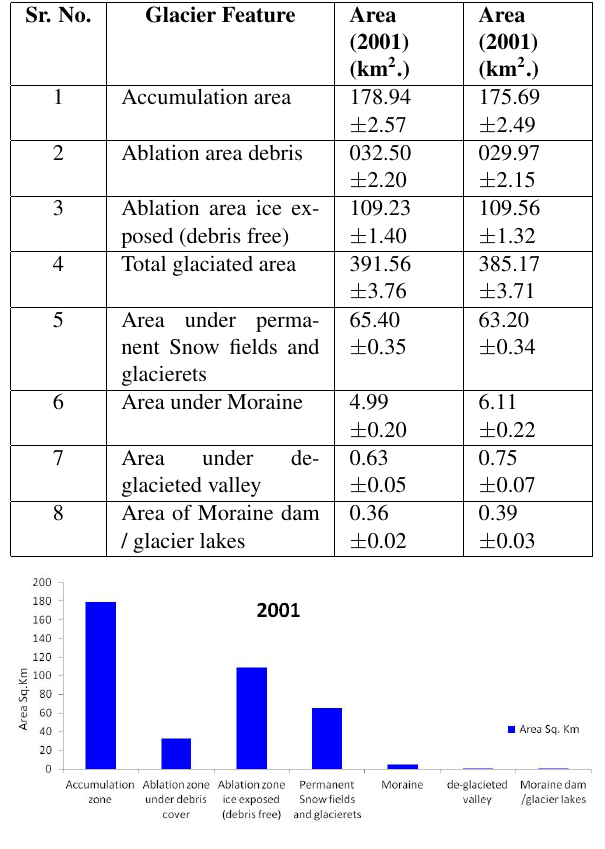
Table 1: Summary of glacier inventory result